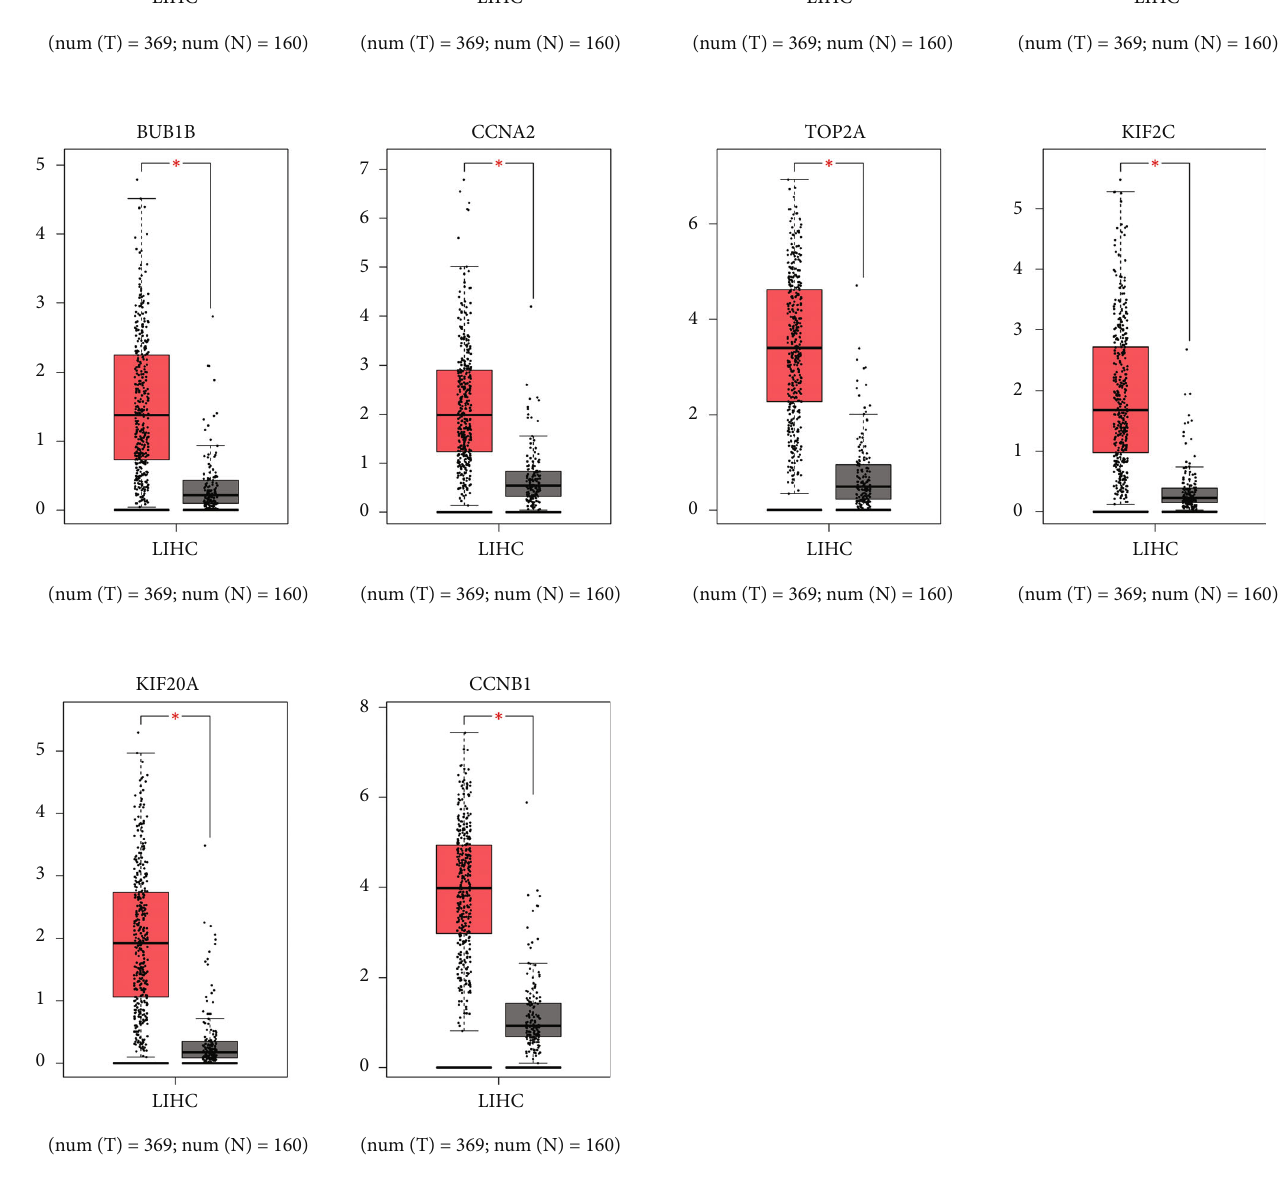
Figure 5: Expression of DEGs in HCC and control tissues. Expression of CDK1, CDC20, CCNB2, BUB1, BUB1B, CCNA2, TOP2A, KIF2C, KIF20A, and CCNB1 in HCC and control tissues were analyzed by GEPIA. LIHC =liver hepatocellular